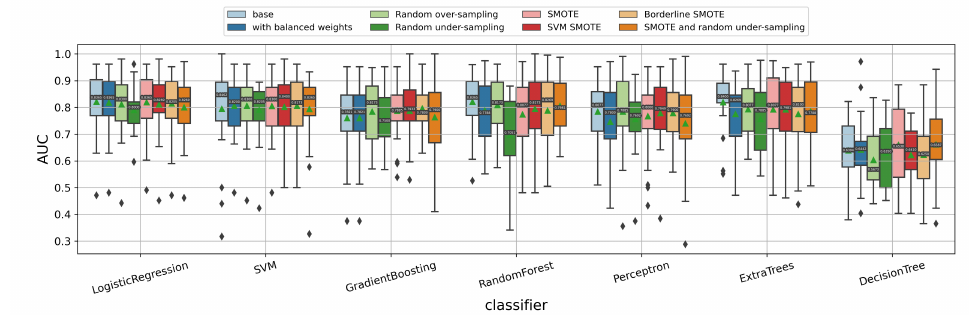
Figure 8. Impact of further data imbalance strategies on predicting the 1p/19q codeletion status of the gliomas. Here, the possible regularization was already applied for each classifier, so “base” means not further using any other data imbalance strategies. “SMOTE and random under-sampling” represents the combination of SMOTE and random under-sampling method.